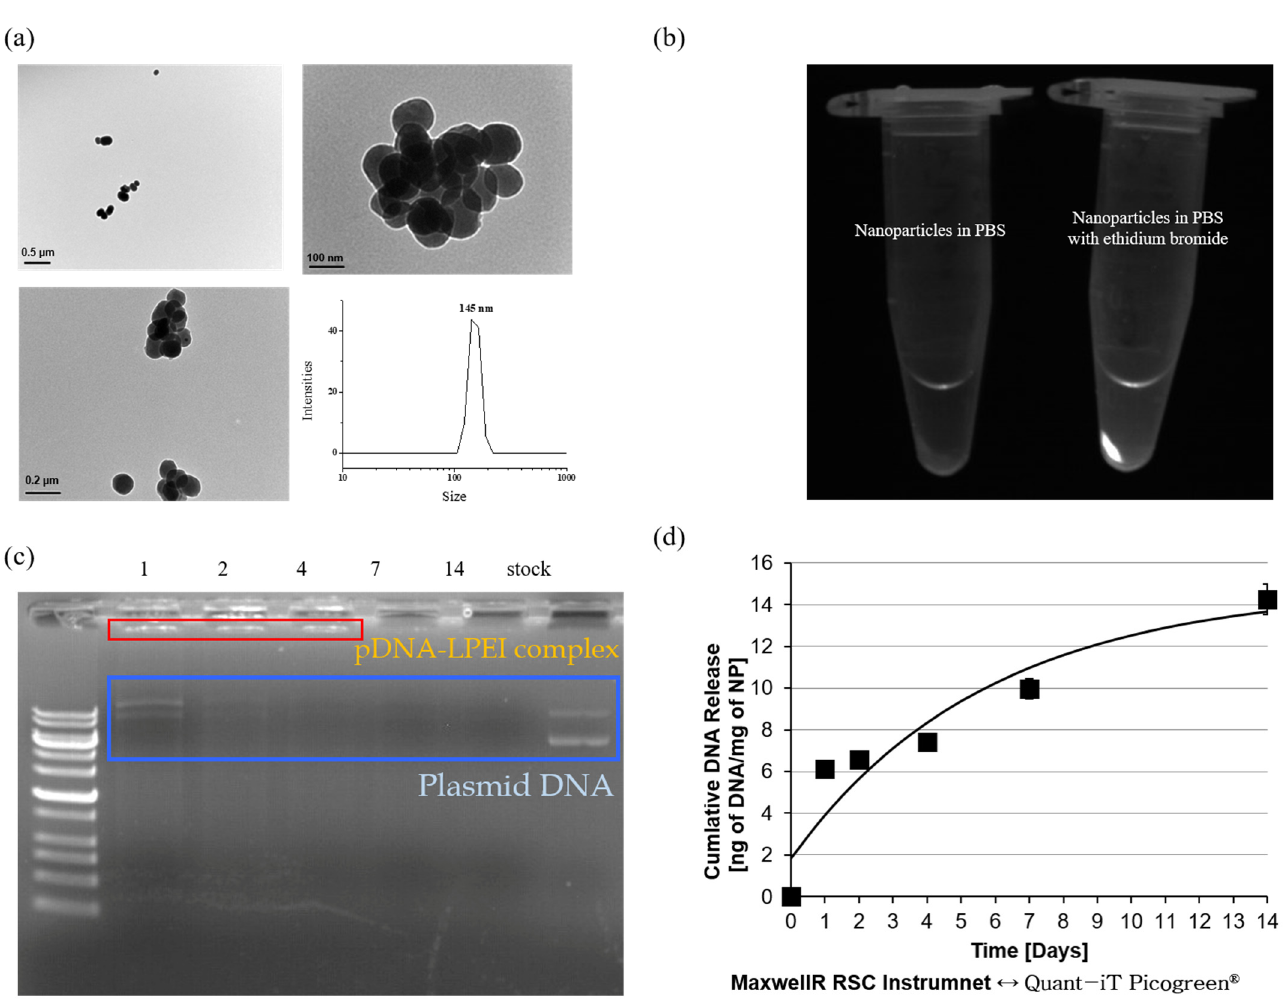
Figure 4. ( a ) TEM and DLS results for pDNA-LPEI LTU nanoparticles; ( b ) pDNA-LPEI LTU nanoparticles with EtBr in PBS for loading confirmation; ( c ) gel electrophoresis image of supernatant obtained from pDNA-LPEI LTU nanoparticles; ( d ) cumulative release of pDNA from pDNA-LPEI LTU nanoparticles with PicoGreen Quantification.